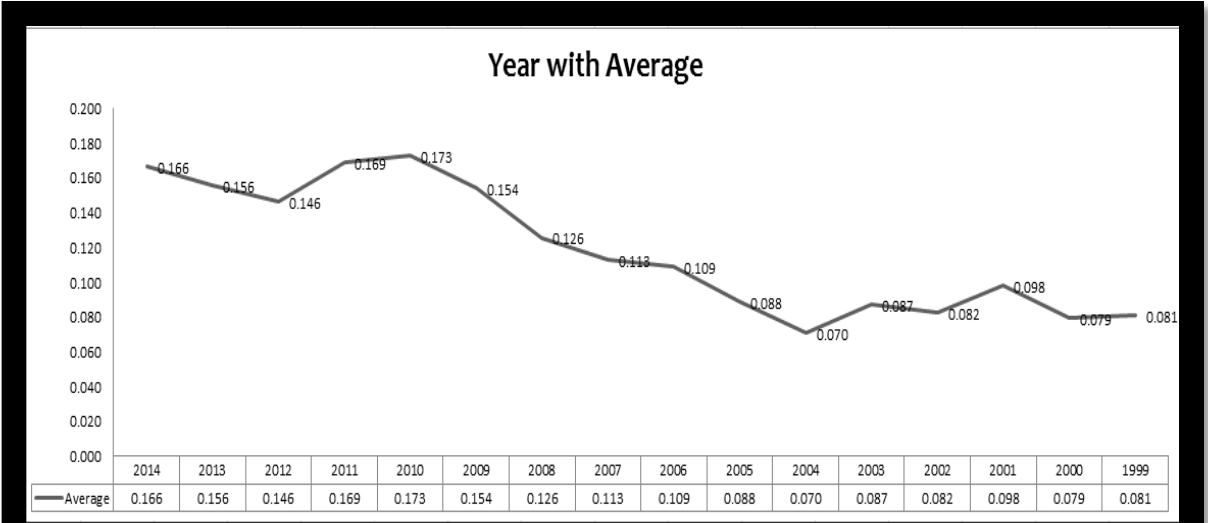
Figure 2. Average cash holding level per year.